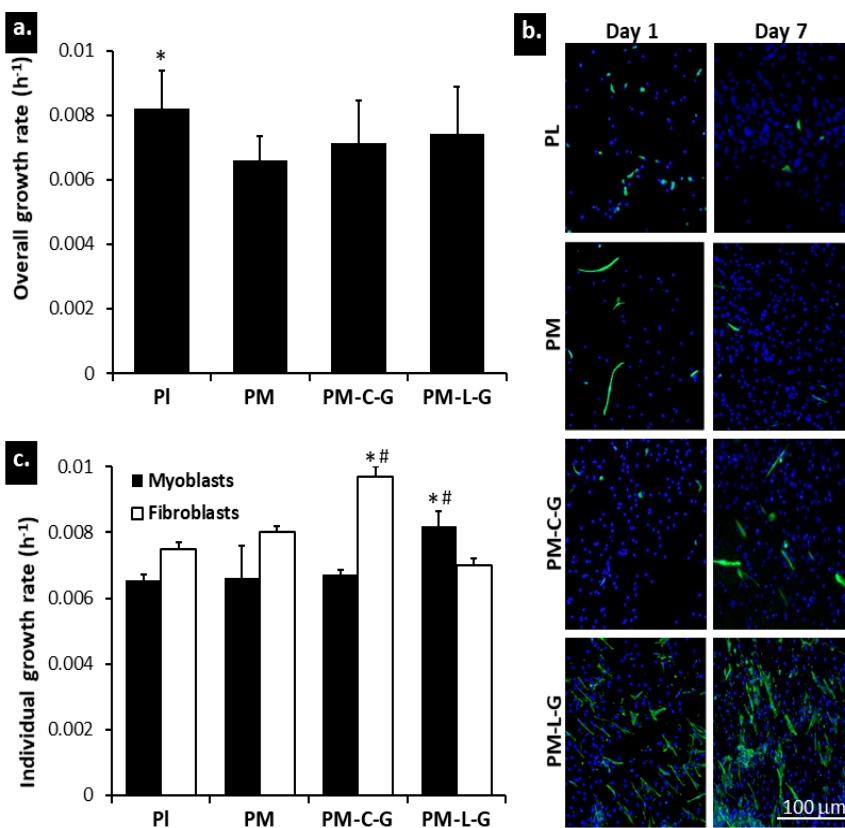
Figure 7. Myoblast and fibroblast ( a ) overall growth rate; ( b ) individual growth rate; and ( c ) cell population at day 1 and day 7. A higher number of cells was found at day 7 compared to day 1.